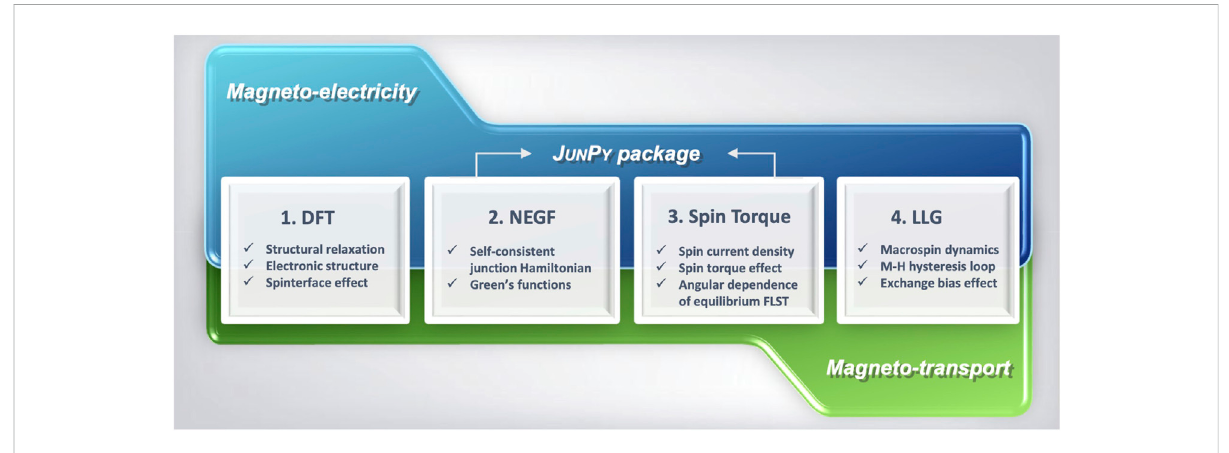
FIGURE 1 DFT + JUNPY + LLG calculation procedure to investigate the magnetoelectric and magnetotransport properties of complex magnetic heterostructures, such as magnetic tunnel junctions (MTJs) [20] and single-molecule magnetic junctions (SMMJs) [21,